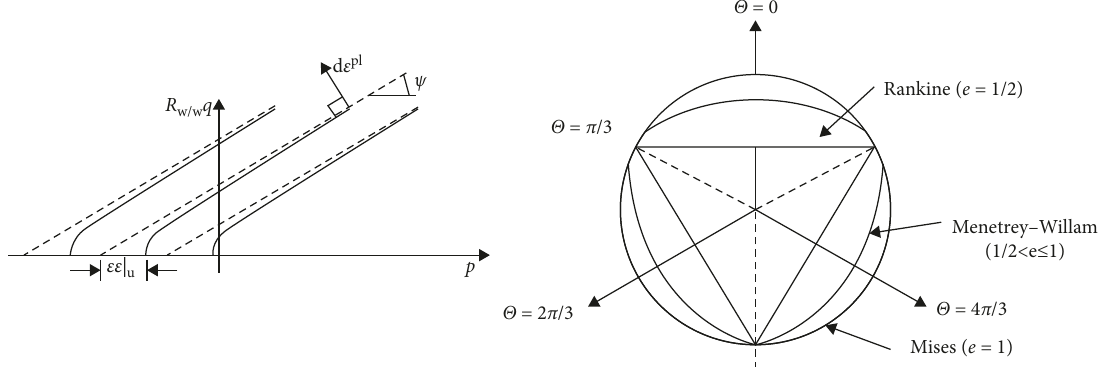
Figure 3: Plastic potential surface in Mohr–Coulomb